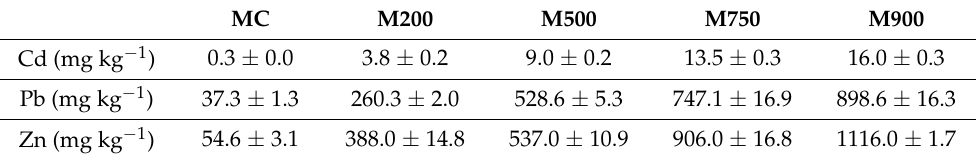
Table 1. Cd, Pb, and Zn pseudo total concentrations in the studied soils (mean ± standard deviation).